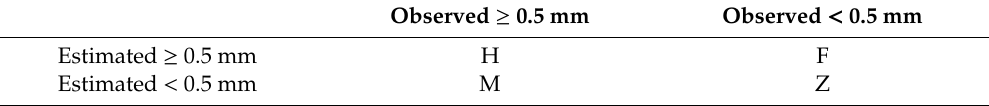
Table 1. A 2 × 2 contingency table for two types of precipitation estimation.